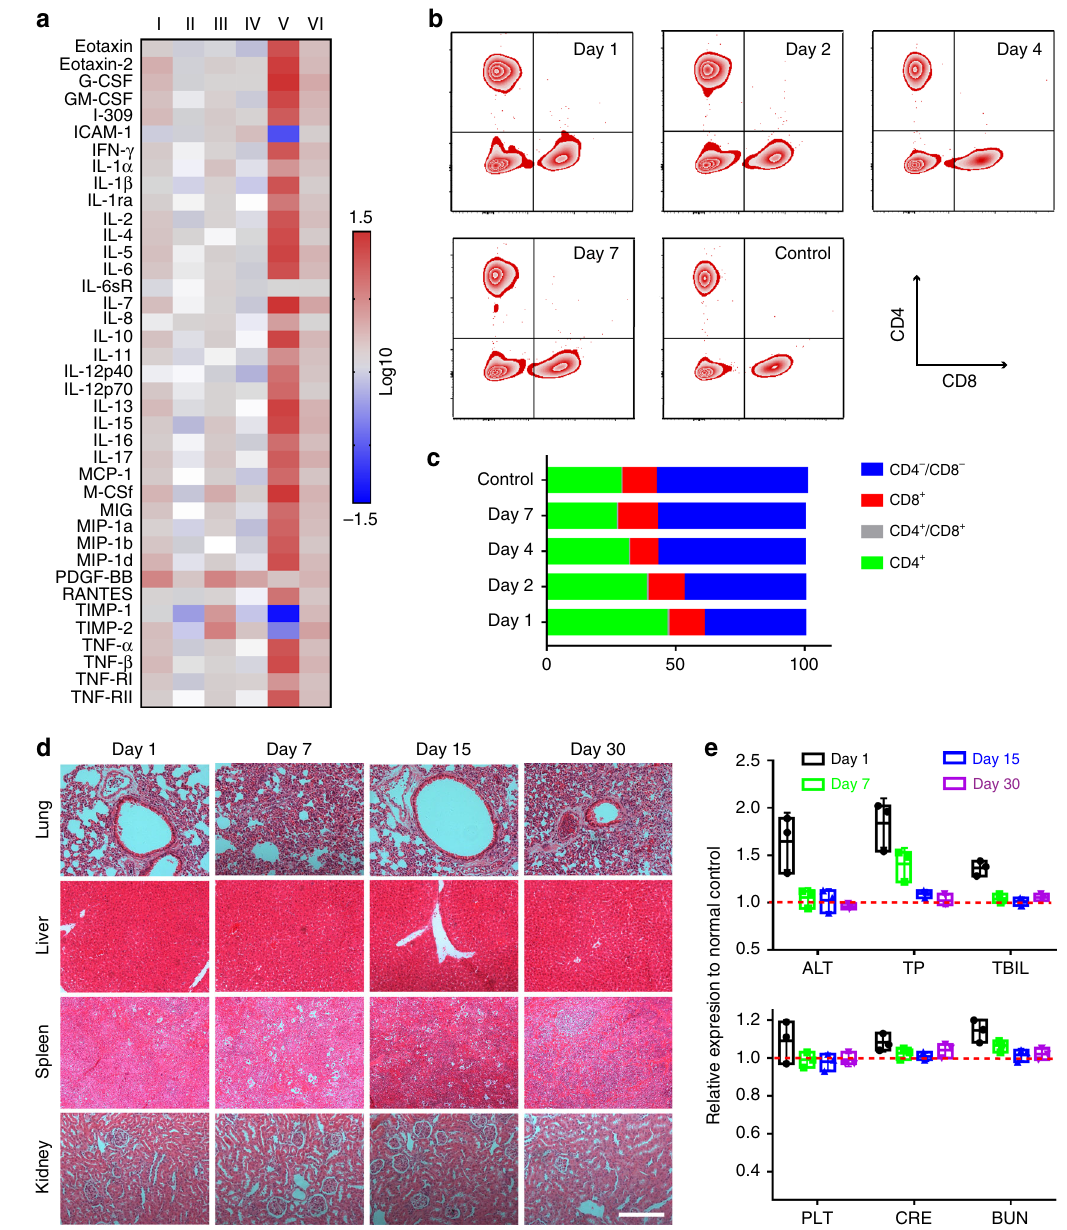
Fig. 10 Long-term safety pro fi le. a A heat-map showing the changes in the expression of a spectrum of in fl ammatory cytokines in the liver tissue ( n = 3 at each time point). Their levels of expression were fi rst analyzed using a protein antibody array, normalized to that of the normal control, and shown in a fold- of-change fashion. Captions I – VI indicate the case of mice received Mito(T)-pep-Nuc(T) (I, II), Mito(T)-pep-Nuc(N) (III, IV), Mito(N)-pep-Nuc(T) (V, VI) at Day 1 (I, III, V) and Day 15 (II, IV, VI) as de fi ned in Fig. 8a. A color bar on the right indicates the color scales. b Pro fi le of systematic pro-in fl ammatory immunity in responding to Mito(T)-pep-Nuc(T)-mediated therapy. The peripheral level of CD4 + and CD8 + T cells were analyzed by fl ow cytometry, and c the population of all four different classes of circulating T cells including CD4 and CD8 dual-positive (CD4 + /CD8 + ) and dual-negative (CD4 − /CD8 − ) and singly positive ones (CD4 + and CD8 + ). d Pathological study of normal mice received i.v. injection of Mito(T)-pep-Nuc(T). The H&E-stained tissue slices of four organs were shown as a function of time post injection. Scale bar: 100 μ m. e Hematological study showing the functions of liver (upper), spleen, and kidney (lower) as a function of time as indicated by the biomarkers for liver (including ALT, TP, TBIL), spleen (PLT, platelet), and kidneys (including BUN (blood urea nitrogen) and CRE (creatinine)). Data are presented as mean ± s.e.m. ( n = 3). In the box plot, the upper and lower quartile as outlined by top and bottom boundary was divided by line showing the median